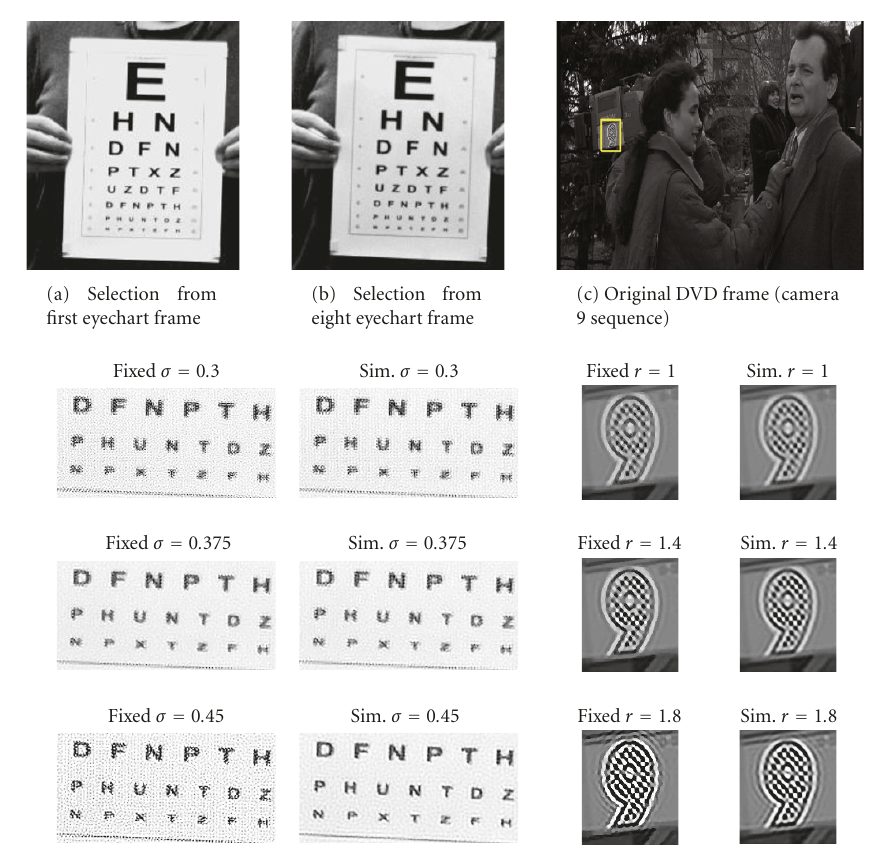
Figure 7: Eyechart sequence and camera “9” sequence. (a), (b) Sections of two input images from the 10-frame eye-test card sequence. Notice the card appears much brighter in the left image. (c) Raw DVD frame for camera “9” sequence (see Figure 1 for close-up of interest region). Lower section, first and third columns: results obtained by fixing registration prior to super resolution. Lower section, second and fourth columns: results obtained using the simultaneous approach to optimize the super-resolution image, registration parameters, and prior